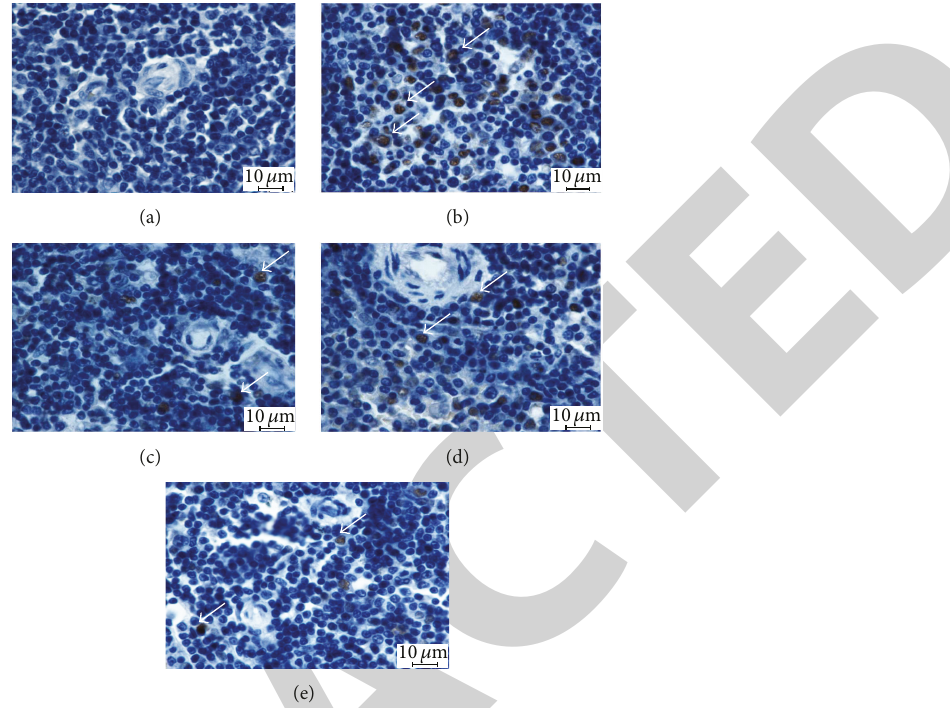
Figure 3: Photomicrographs showing immunohistochemical staining of PCNA of spleens from the different experimental groups. Control group: showing normal spleen architecture, (b) TAA group (hepatotoxic group): showing more PCNA expression (white arrows), (c) SY + TAA group: showing mild PCNA positive in the spleen, (d) CS100 + TAA group: showing moderate PCNA expression, and (e) CS300 + TAA group: showing mild PCNA expression. (Bar scale: 10 𝜇 m).